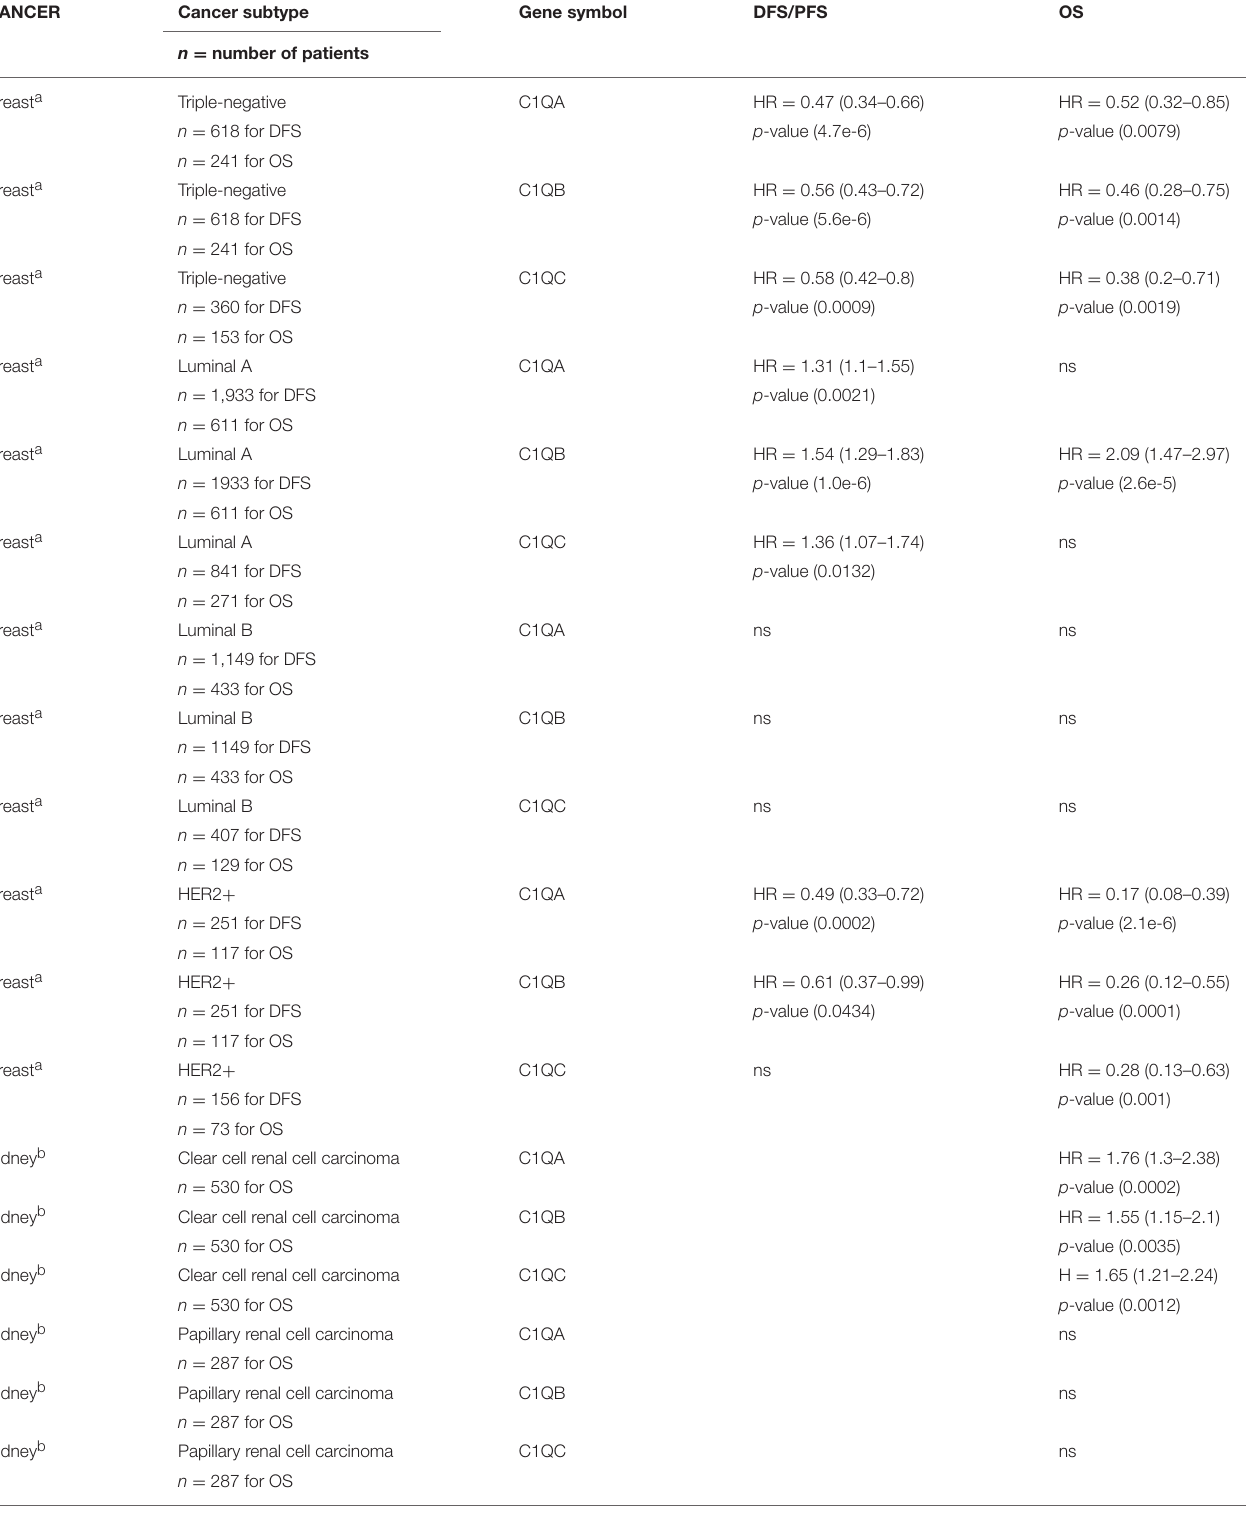
TABLE 1 | Prognostic significance of C1q in patients with carcinomas.